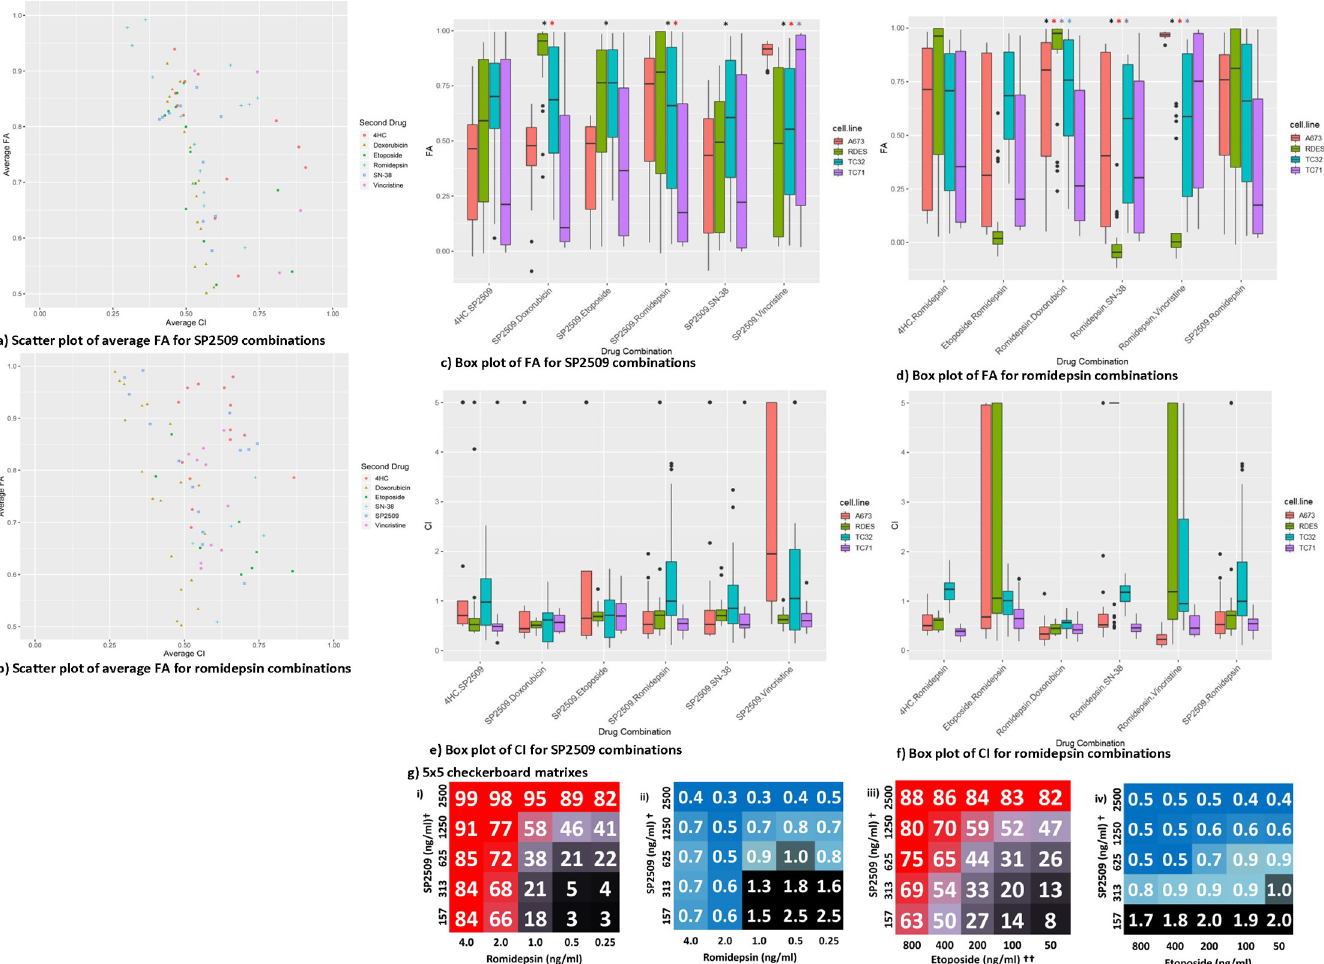
Fig 2. Overview of combination efficacy for SP2509 and romidepsin combinations. Scatter plots displaying the average fraction of cells affected (FA) for drugs paired with a) SP2509 and b) romidepsin. Box plot for c) SP2509 exhibiting the FA of each cell line for all drug combinations. A black asterisk indicates a significantly higher FA value than 4HC+SP2509. P-values as follows: SP2509+doxorubicin = 1.87x10 -25 , SP2509+etoposide = 2.54x10 -16 , SP2509+romidepsin = 6.72x10 -15 , SP2509+SN- 38 = 2.81x10 -08 , SP2509+vincristine = 1.02x10 -18 . A red asterisk indicates a significantly higher FA value than SP2509+etoposide. P-values as follows: SP2509 +doxorubicin = 1.66x10 -09 , SP2509+romidepsin = 3.43x10 -06 , SP2509+vincristine = 1.28x10 -11 . A purple asterisk indicates a significantly higher FA than SP2509 +doxorubicin. P-value as follows: SP2509+Vincristine = 3.19x10 -05 . Statistics based on combined value from all cell lines and all concentrations. Box plot for d) romidepsin exhibiting the FA of each cell line for all drug combinations. A black asterisk indicates significantly higher FA than romidepsin+etoposide. P-values as follows: romidepsin+doxorubicin = 8.56x10 -07 , romidepsin+SN-38 = 6.97x10 -07 , romidepsin+vincristine = 7.23x10 -19 . A red asterisk indicates significantly higher FA than romidepsin+SP2509. P-value as follows: romidepsin+doxorubicin = 0.00011, romidepsin+vincristine = 2.26x10 -12 . A purple asterisk indicates significantly higher FA value than romidepsin+4HC. P-value as follows: romidepsin+vincristine = 8.11x10 -11 . Statistics based on combined value from all cell lines and all concentrations. Box plots for e) SP2509 and f) romidepsin exhibiting the CI for each cell line for all drug combinations. g) 5x5 Checkerboard matrixes assessing combination activity. i) FA and ii) CI values for SP2509 and romidepsin assessed at 25 different concentrations. † Alternate SP2509 concentrations used (1000, 500, 250, 125, 62.5ng/ml for A673 and RD-ES cell lines; 2000, 1000, 500, 250, 125ng/ml used for TC32 cell line). Variable concentrations used due to differences in IC 50 per cell line. iii) FA and iv) CI values for SP2509 and etoposide assessed at 25 different concentrations. †† Alternate etoposide concentrations used (300, 150, 75, 37.5, 18.8ng/ml used for A673 cell line).